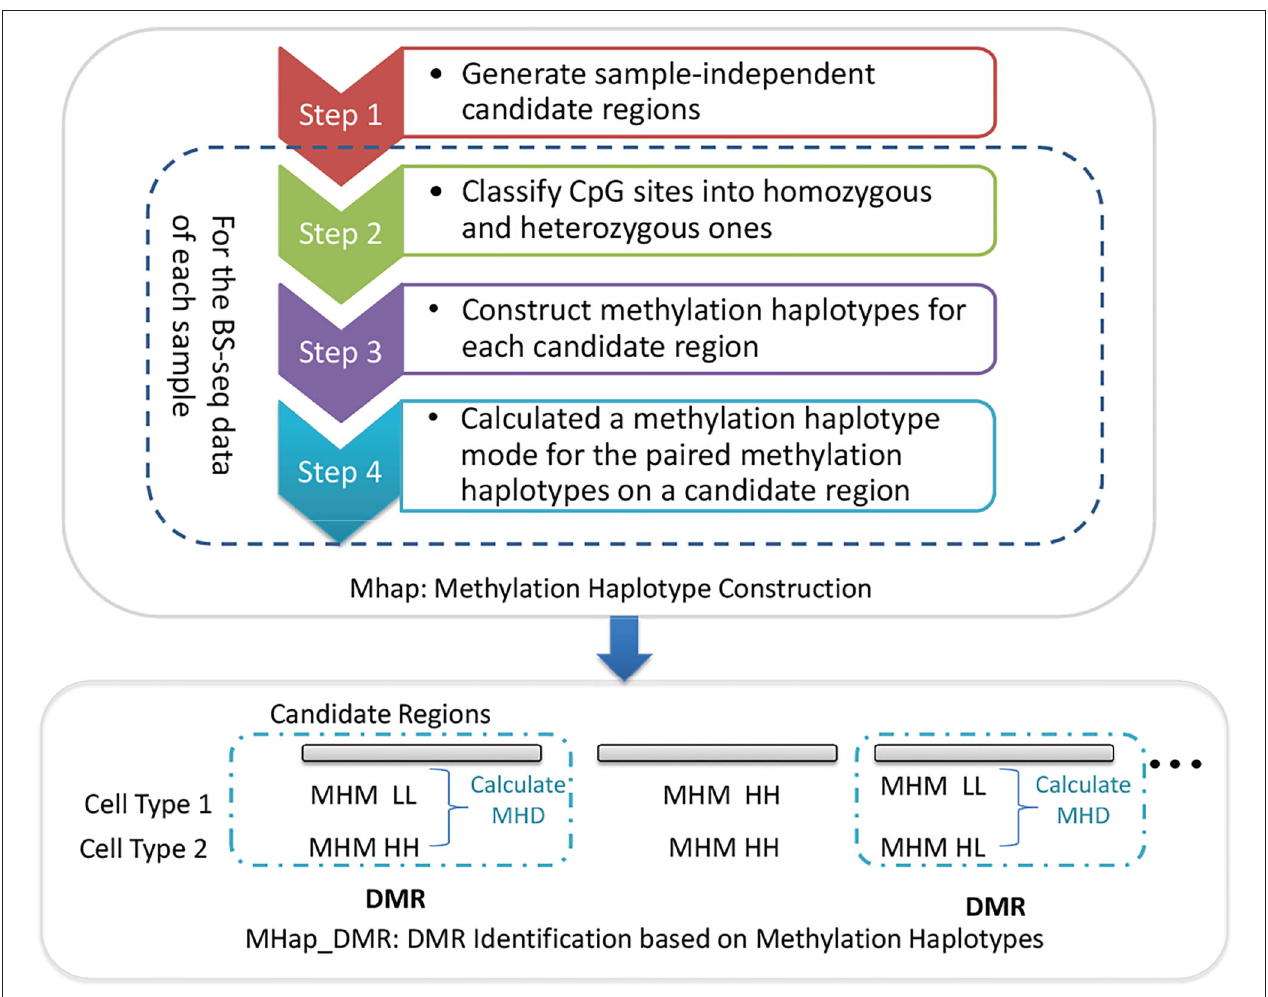
FIGURE 1 | The framework of MHap and